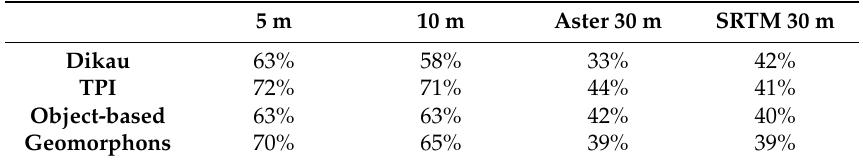
Table 7. Overall accuracy of the four approaches and the four different datasets derived as the relation of correctly classified to all classified elements from the confusion matrices (Tables